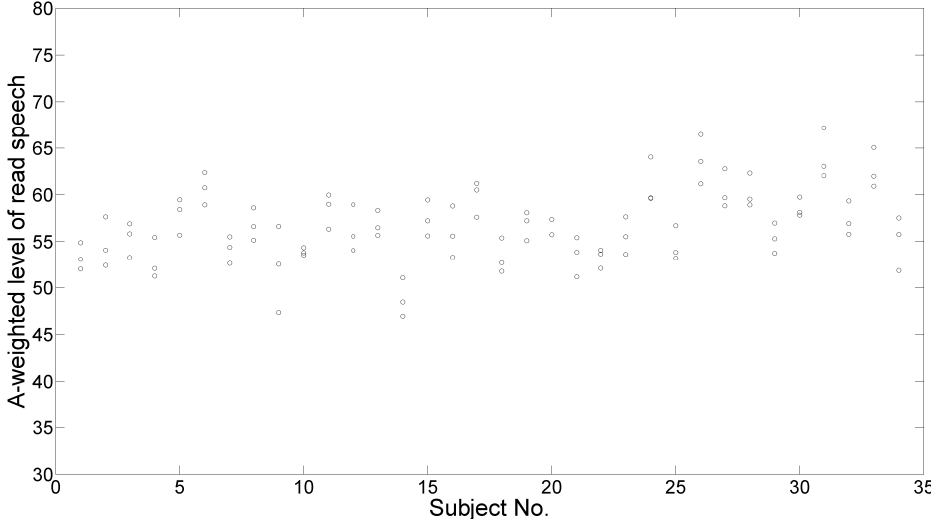
Figure 4. The range of observations provided by each subject for the A-weighted level of speech in the reading part of the experiment. the reading part of the